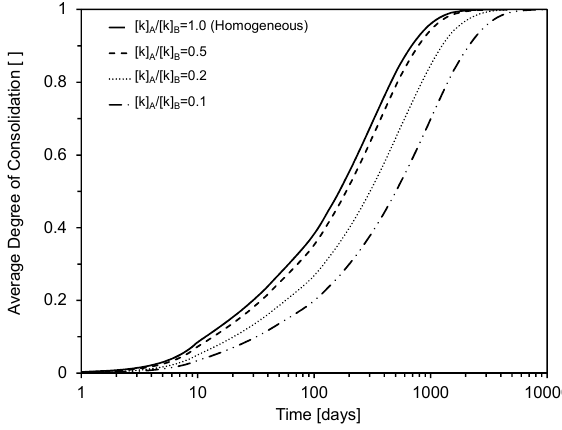
Figure 2. Effects of k variability on one-dimensional consolidation process of soils with binary layers. All the cases have the same mean of consolidation coefficient and the same thickness ratio t/H = 0.05.